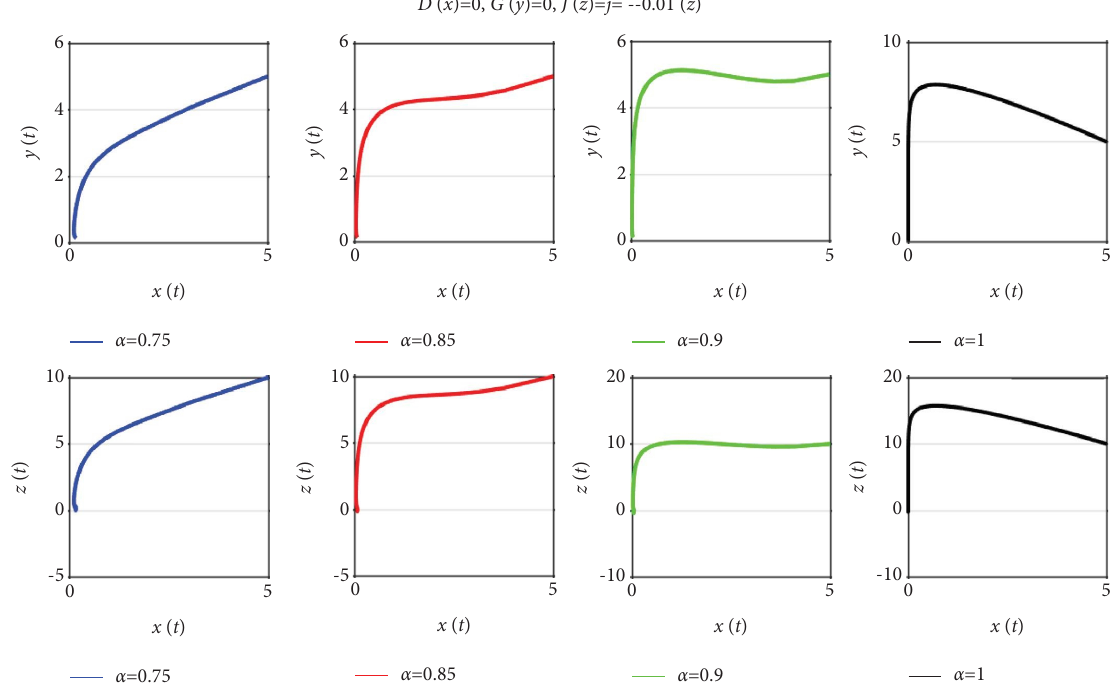
Figure 13: Phasespacefortheoneprey-twopredatorssystem,where D ( x ) � 0 , G ( y ) � 0 , J ( z ) � − j / z � − 0 . 01/ z, a � b � c � 0 . 1 , e � h � 0 . 3 , f � i � 0 . 2 , and α � 0 . 75 , 0 . 85 , 0 . 9 , 1